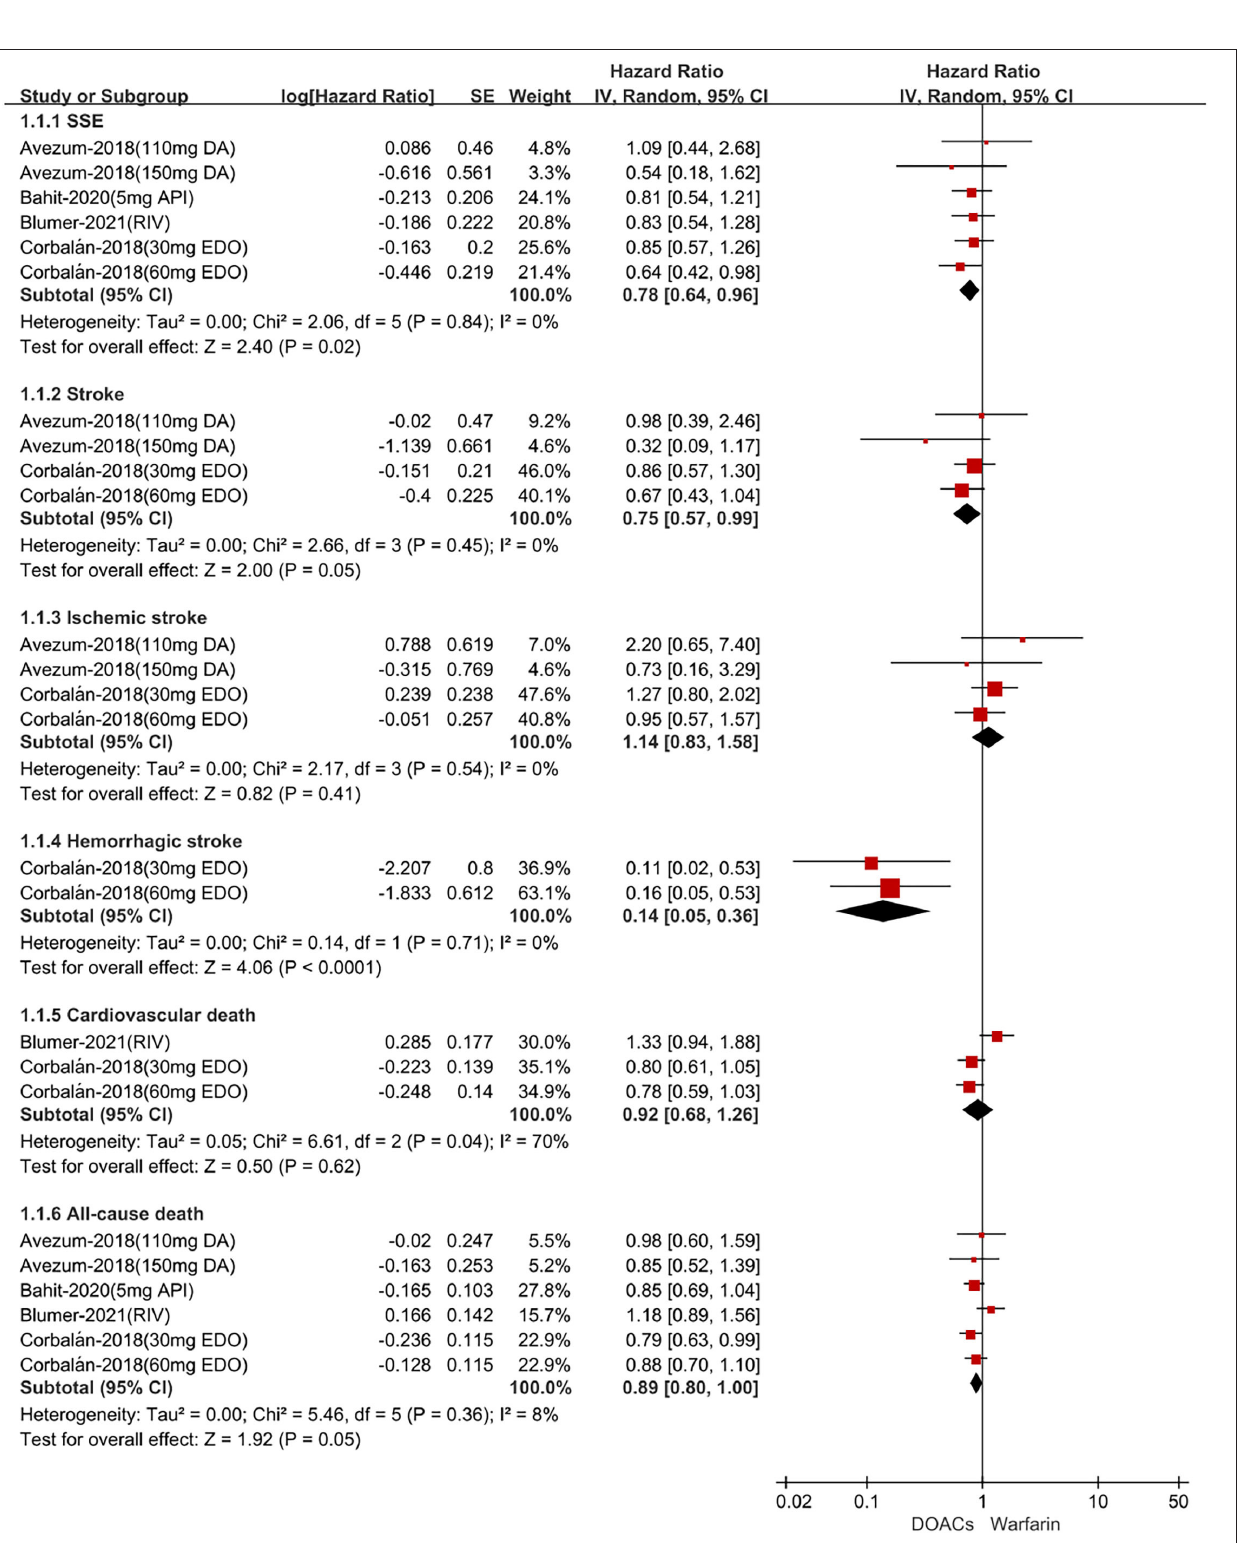
Frontiers in Cardiovascular Medicine |